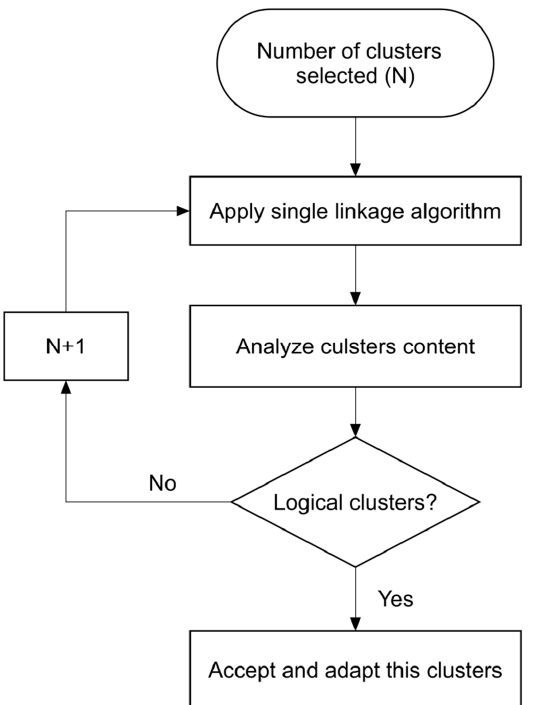
Figure 3. Flowchart describes steps used to determine number of clusters .